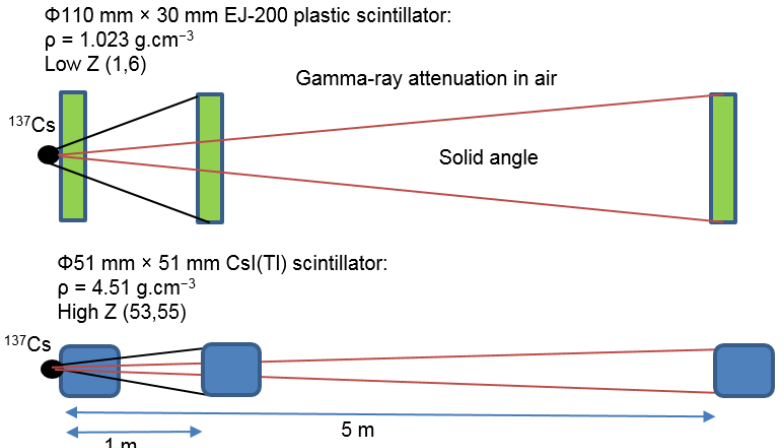
Figure 7. Parameters that influence the detection efficiency of EJ-200 and CsI(Tl) scintillators when considering source attached to the detector window, 1 m and 5 m